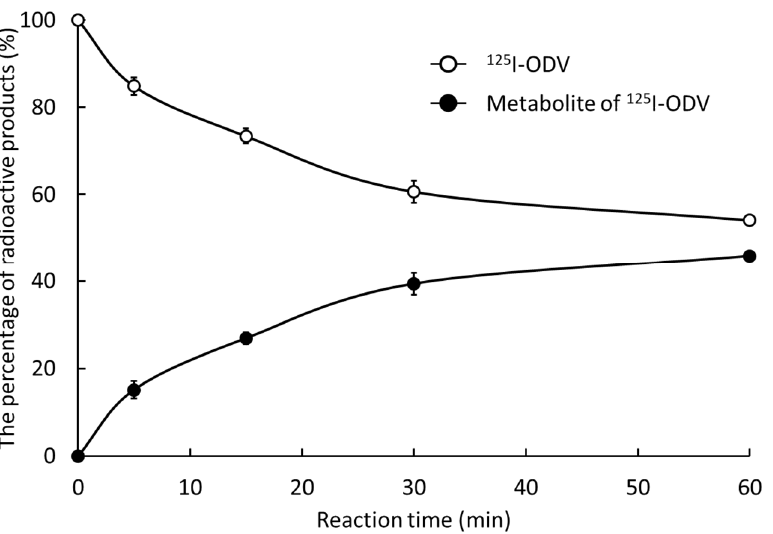
Figure 4. The percentage of 125 I-ODV and its metabolite. Depending on the reaction time, 125 I-ODV decreased and the metabolite of 125 I-ODV increased. After 30 min of reaction time, the percentage of 125 I-ODV and its metabolite became mostly constant.